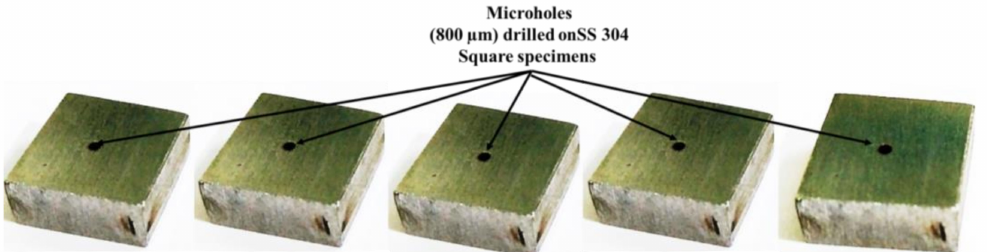
Figure 6. Microholes fabricated on square SS 304 specimens by micro spark-erosion drilling ( µ -SED) process using rotating brass hollow tool electrode of 800 µ m